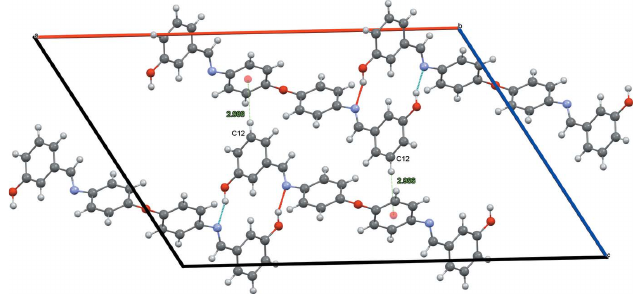
Figure 2 The layer structure viewed along the c -axis direction. The intermolecular O—H (cid:2)(cid:2)(cid:2) N and C—H (cid:2)(cid:2)(cid:2) O hydrogen bonds are shown as red and black dashed lines, respectively.